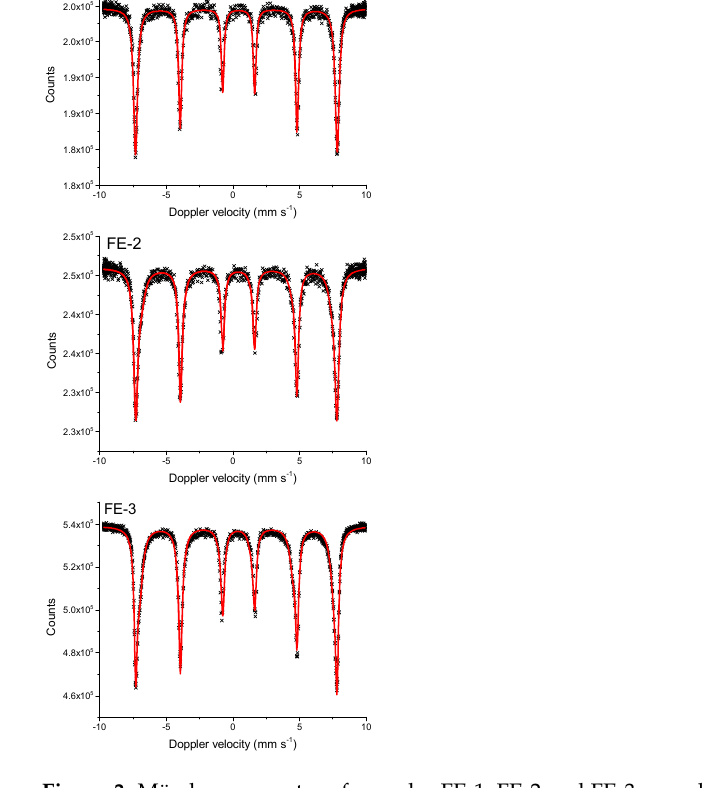
Figure 3. Mössbauer spectra of samples FE-1, FE-2 and FE-3 recorded at 20 °C. Table 1. 57 Fe Mössbauer parameters of samples FE-1, FE-2 and FE-3 recorded at 20 °C.